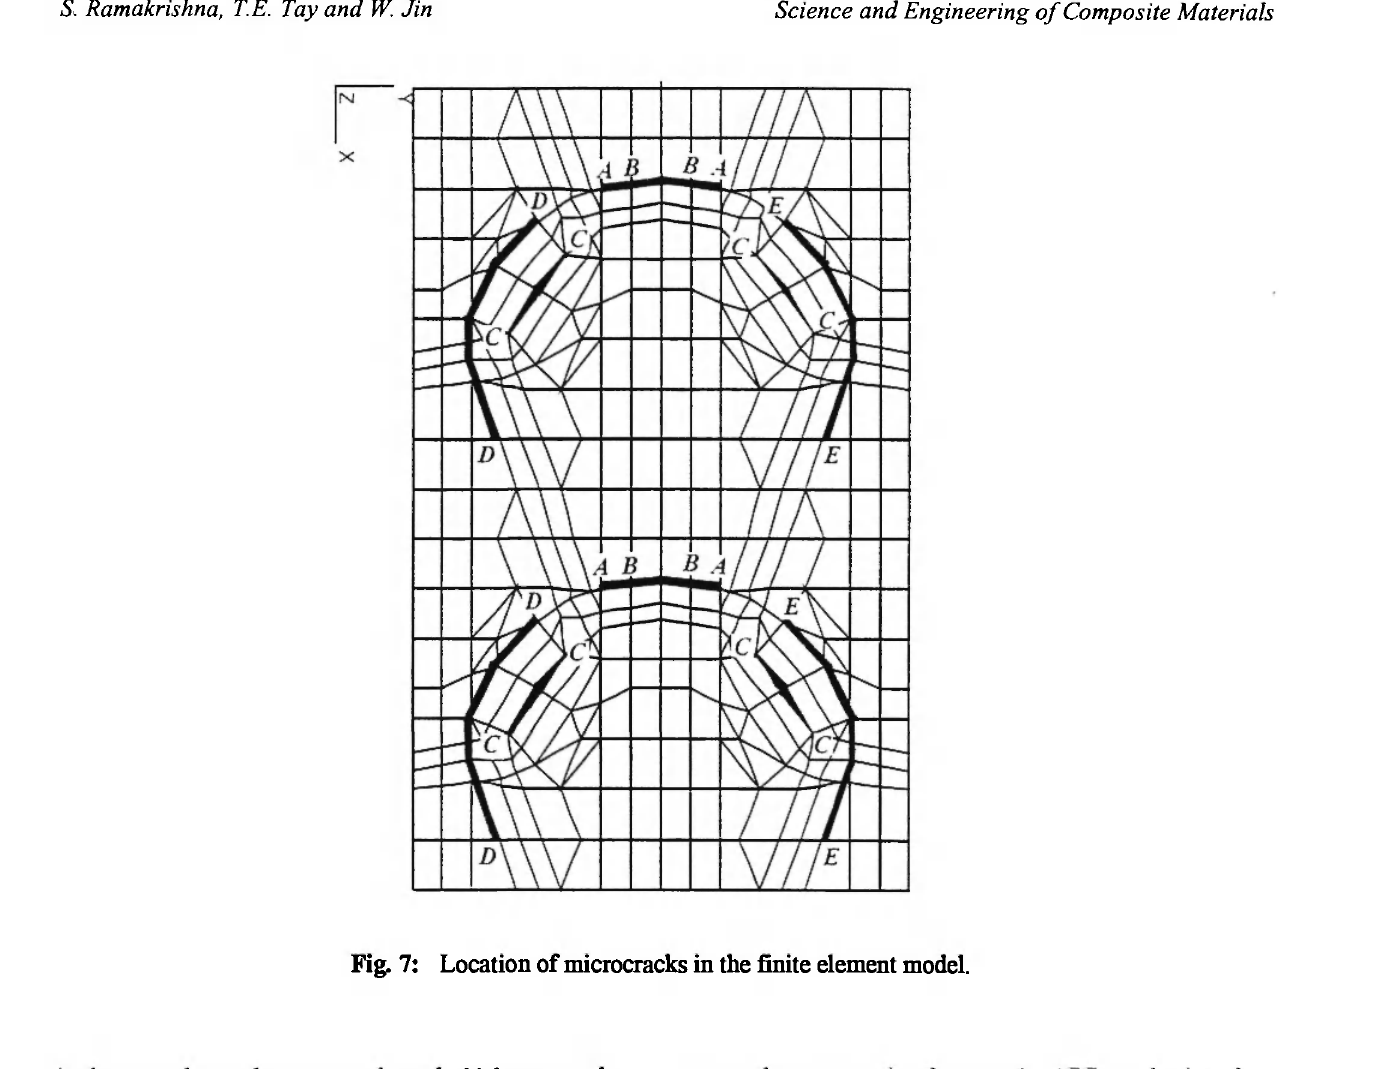
Fig. 7: Location of microcracks in the finite element